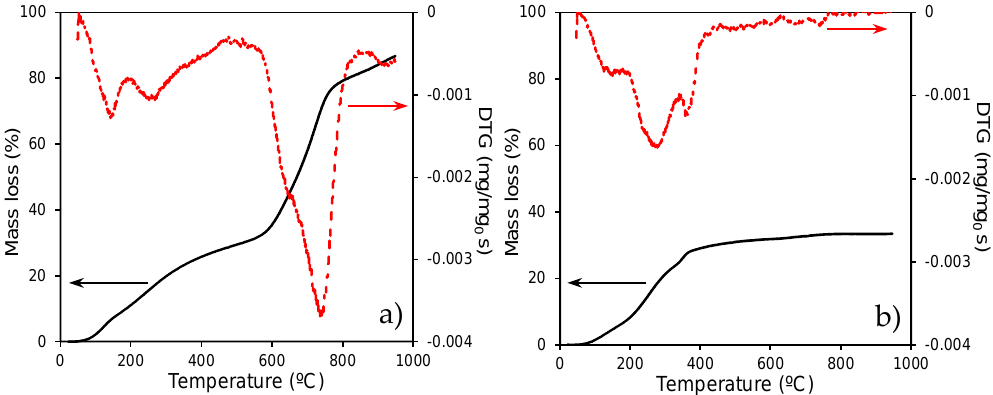
Figure 2. XRD patterns of the different carbon-phosphorus-Ti composites treated at 800 ◦ C.